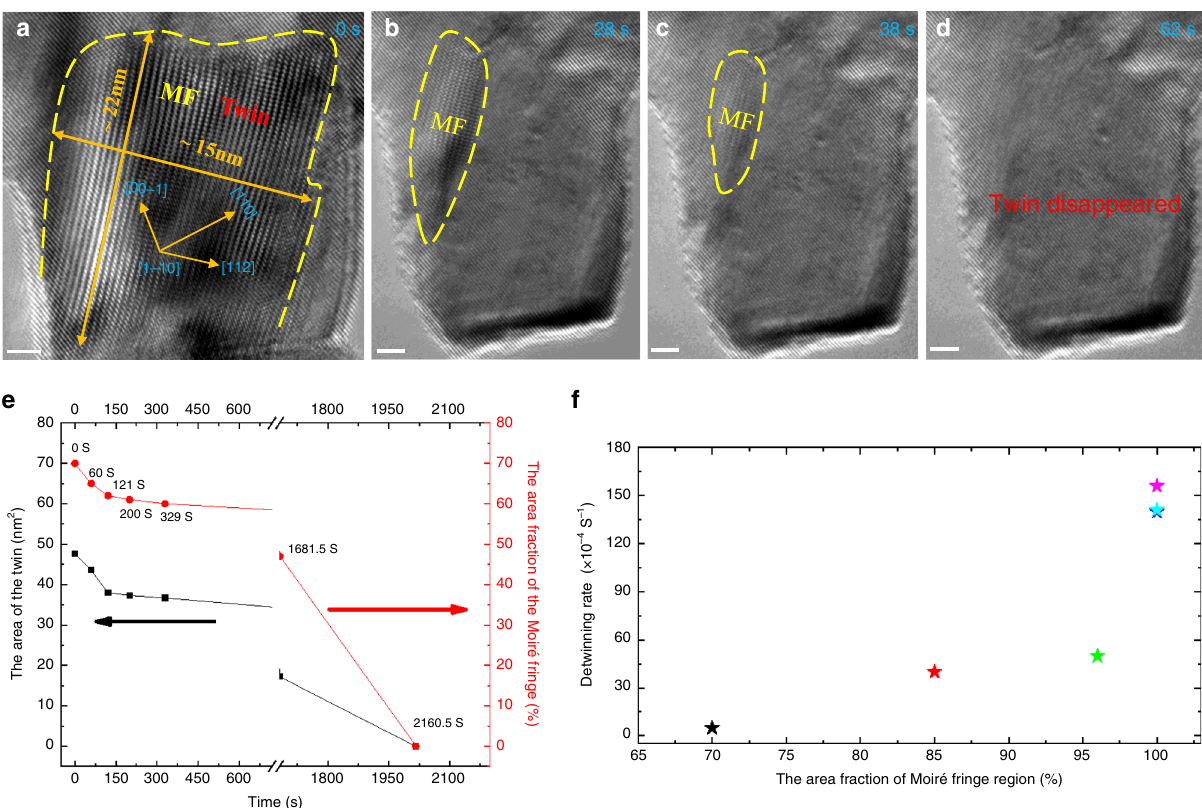
Fig. 3 Dependence of the twin instability on the portion of the inclined twin boundary. a – d Detwinning in the twin with full Moiré fringes and ~15 nm thickness. e Development of the twin and the area fraction of the Moiré fringes with the detwinning time. f The dependence of the average detwinning rate on the area fraction of the Moiré fringes region. Scale bar in a – d is 2 nm.